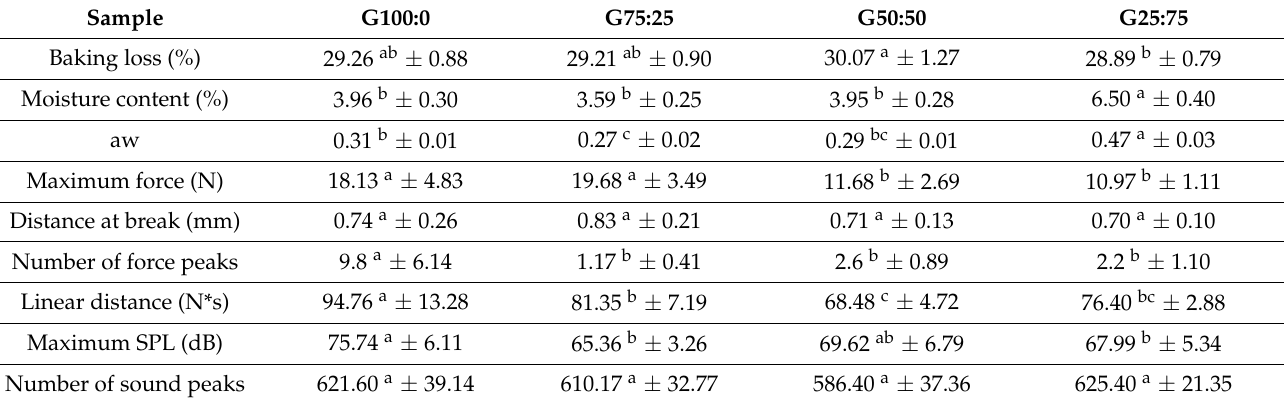
Table 5. Mechanical and acoustic properties, baking loss, moisture content and water activity (aw) of the four chickpea biscuits (mean value of 3 measurements and standard deviation are shown). Parameters for mechanical properties: maximum force required to break (N), distance at break (mm), number of force peaks (peaks higher than 0.2 N) and linear distance (N*s). Parameters for acoustic properties: maximum sound pressure level (dB) and number of sound peaks. G100:0 = 100%